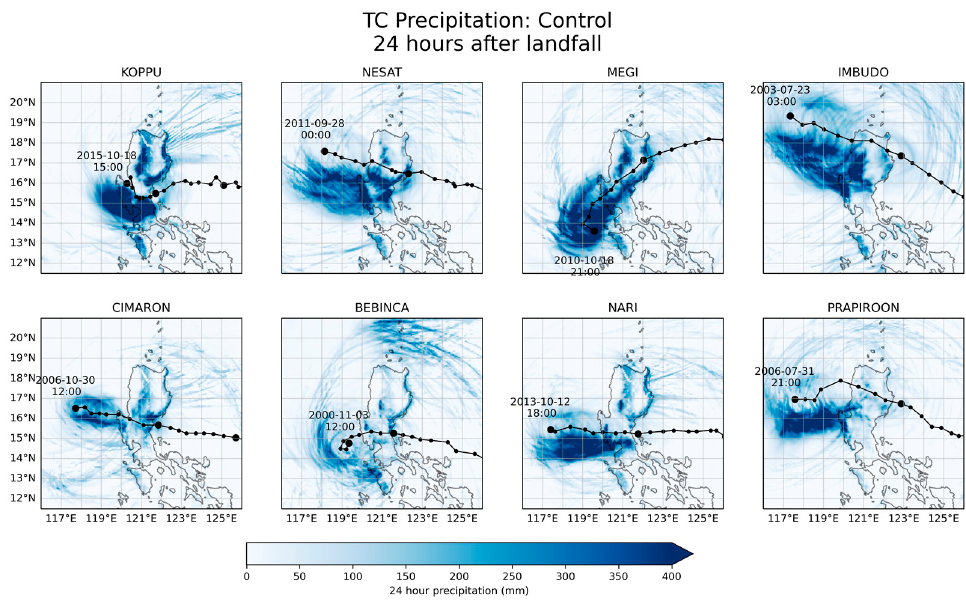
Figure 4. Accumulated precipitation 24 h after simulated landfall (shading) for Control, with the simulated 3-hourly TC tracks in black lines. Tracks are plotted up to 24 h after landfall, with each 24 h period plotted in larger markers.